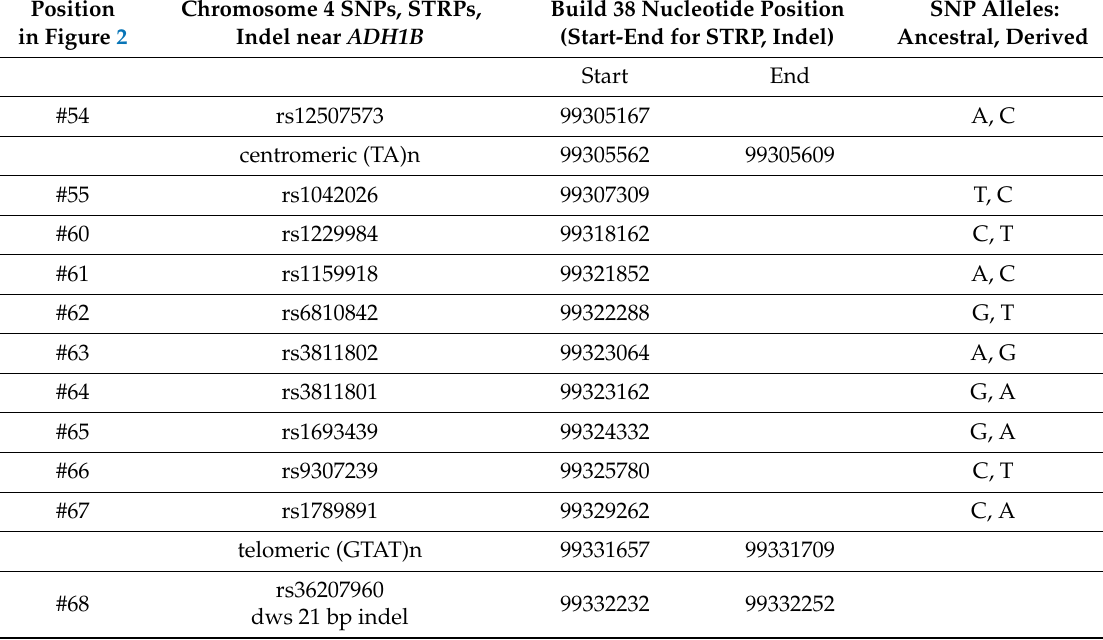
Table 1. The two STRPs and the core haplotype SNPs (#60–66 in Figure 2) analyzed at ADH1B with their nucleotide positions, and ancestral/derived alleles (forward